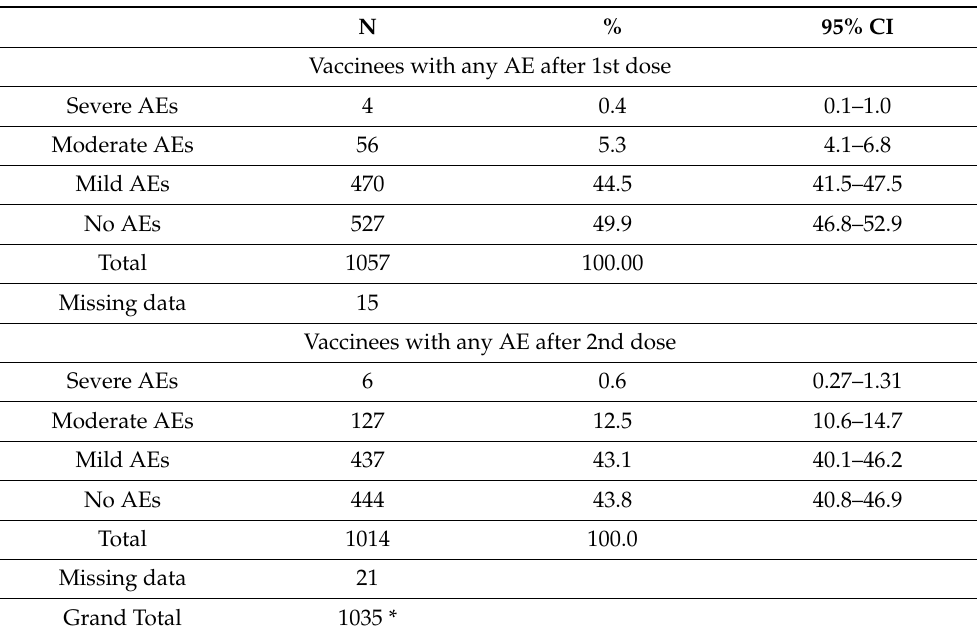
Legend: The percentages are based on the total number of respondents without missing values. Ranking of adverse events was individual, without objective criteria. AE: adverse events. * Vaccinees with 2nd dose and vaccinees without one single-shot vaccine